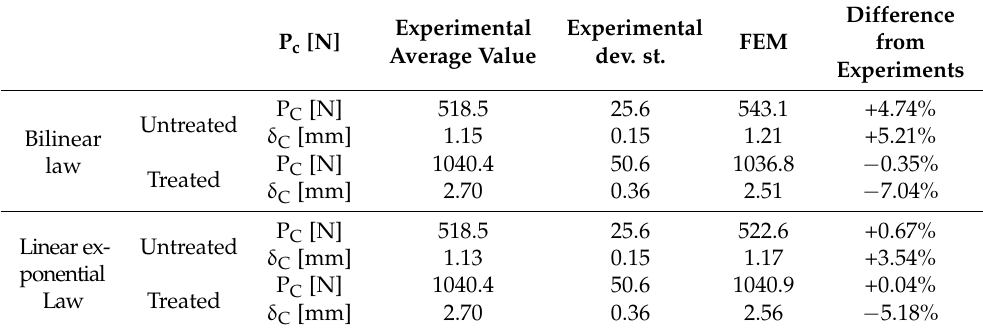
Table 7. Comparison between experimental results and numerical